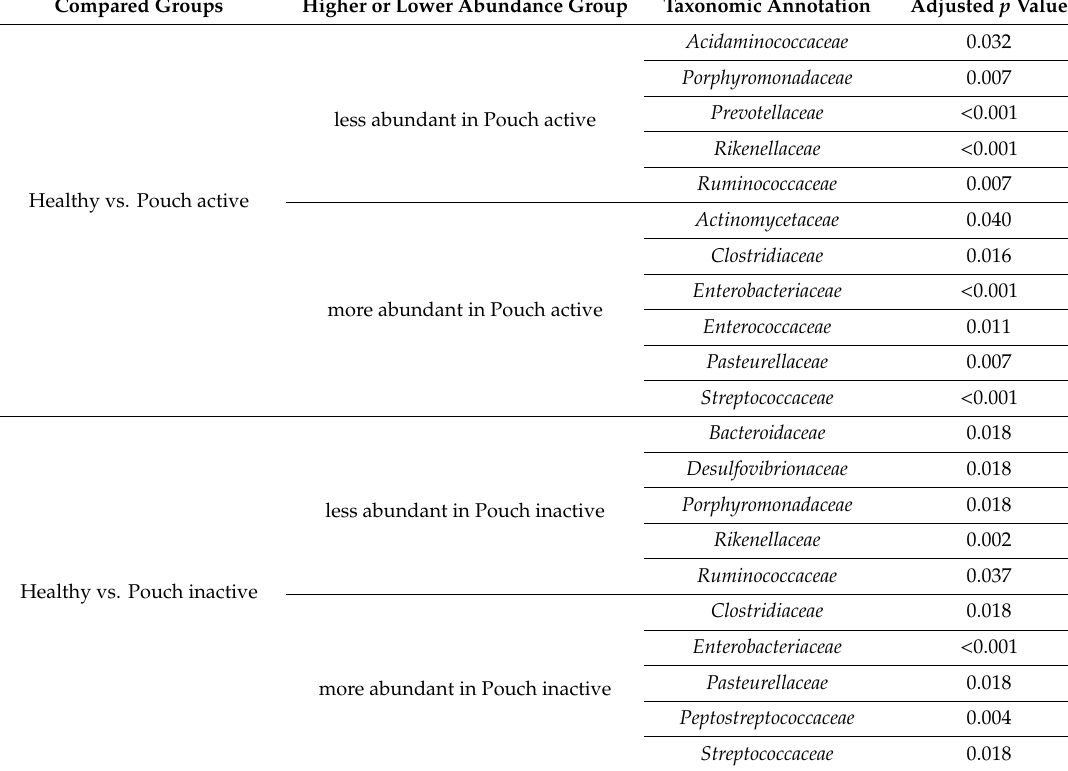
Table 2. Di ff erences in bacterial family abundance between compared groups. Some taxa were identify to less or more abundant in compared groups. Only significant shifts are